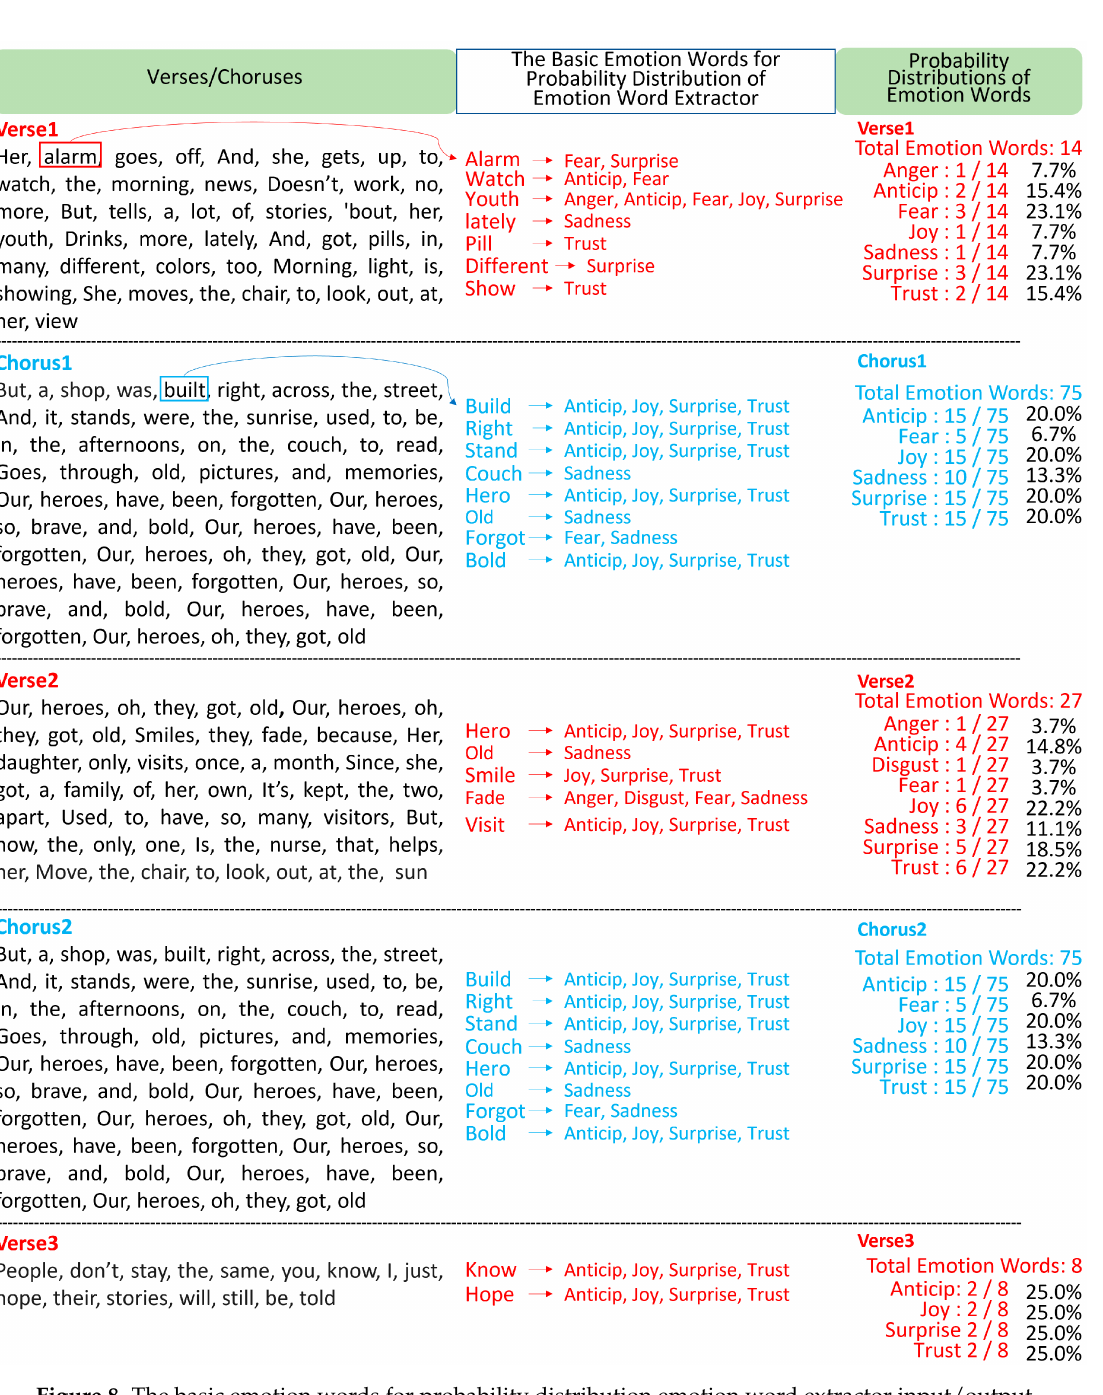
Figure 8. The basic emotion words for probability distribution emotion word extractor input/output. The representative emotion image selector compares the similarity with the probability distributions of emotion words extracted through step 1 and probability distributions of the emotion images tags and selects the images for each verse and chorus, as shown in Figure 9. The probability distribution that is similar to the corresponding probability distribution is searched in the dataset of emotion images with tags. Verse 1 has the most similar probability distribution to the probability distribution of (A) and Chorus 1 has the most similar probability distribution to the probability distribution of